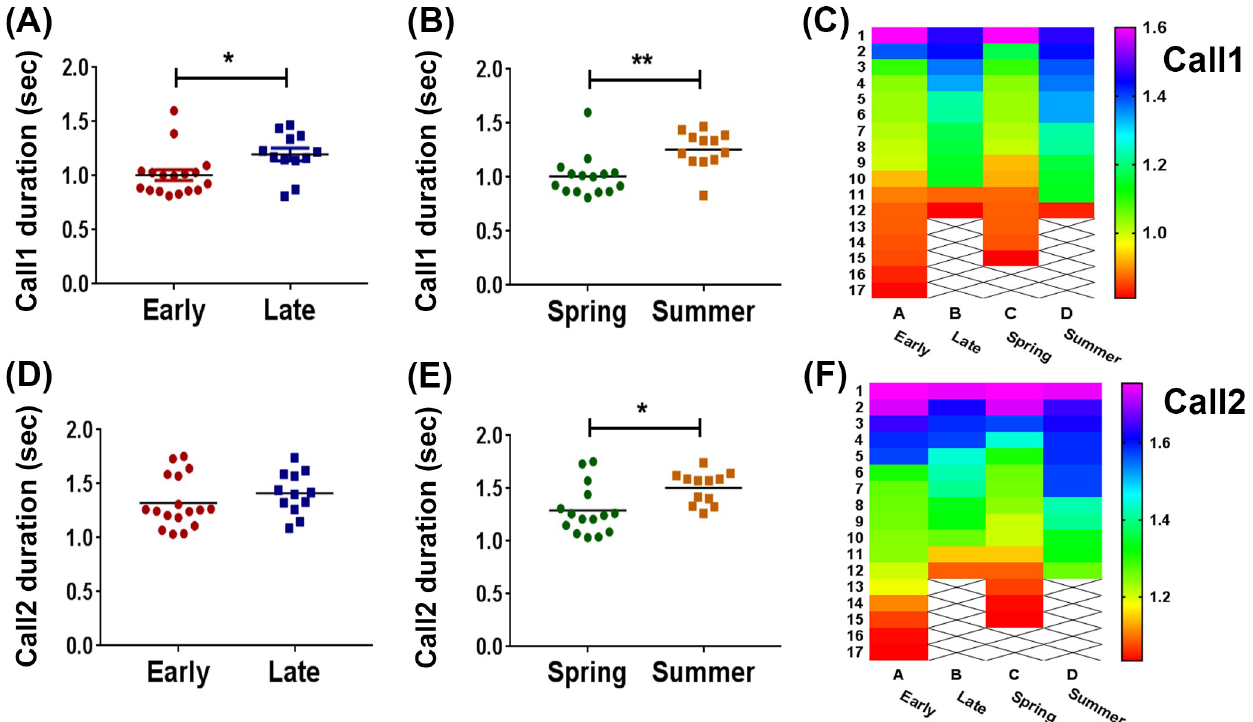
Fig 2. Daily and seasonal variation in call duration. (A) Call1 duration in early vs. late owls (p = 0.0197), (B) Call1 duration in spring vs. summer owls (p = 0.0019), (C) Heat map for Call1. (D) Call2 duration in early vs. late owls (p = 0.3043). (E) Call2 duration in spring vs. summer owls (p = 0.0109), (F) Heat map for Call2. Data from scatter dot plots represent the mean value for each owl. In heat maps, each row corresponds to the mean value per owl, and the columns represent the different groups (n = 17 for early owls, n = 12 for late owls, n = 15 for spring owls, and n = 12 for summer owls). �� p < 0.01, � p < 0.05, two-tailed Student